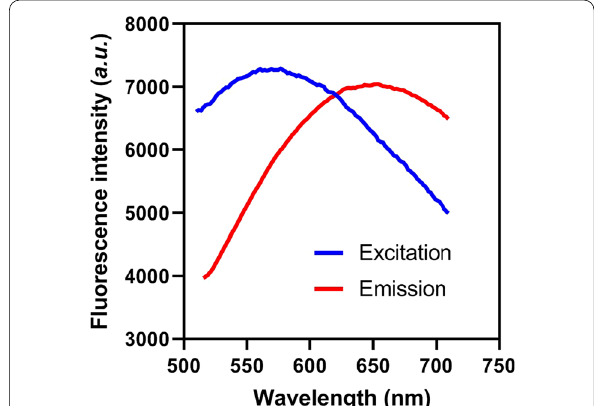
Fig. 2 Excitation spectrum (blue curve) and emission spectrum (red curve) of DNA-templated AgNCs. Emission spectrum was recorded with excitation at 560 nm, and excitation spectrum was recorded for